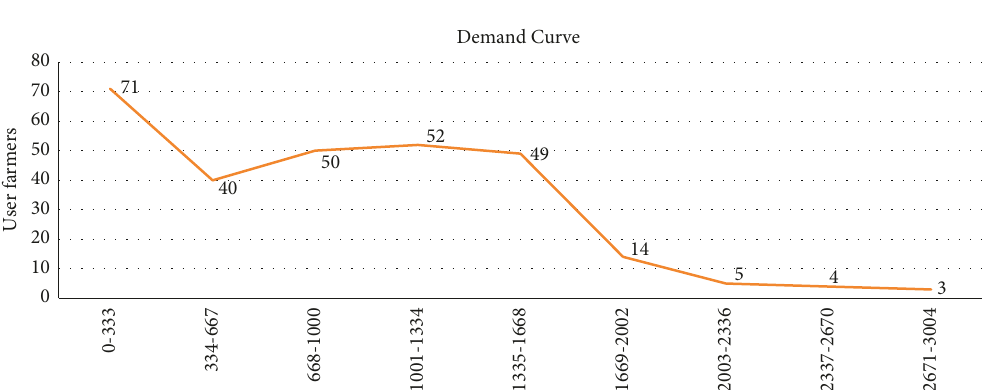
Figure 3: Sample households demand curve Source: survey data,